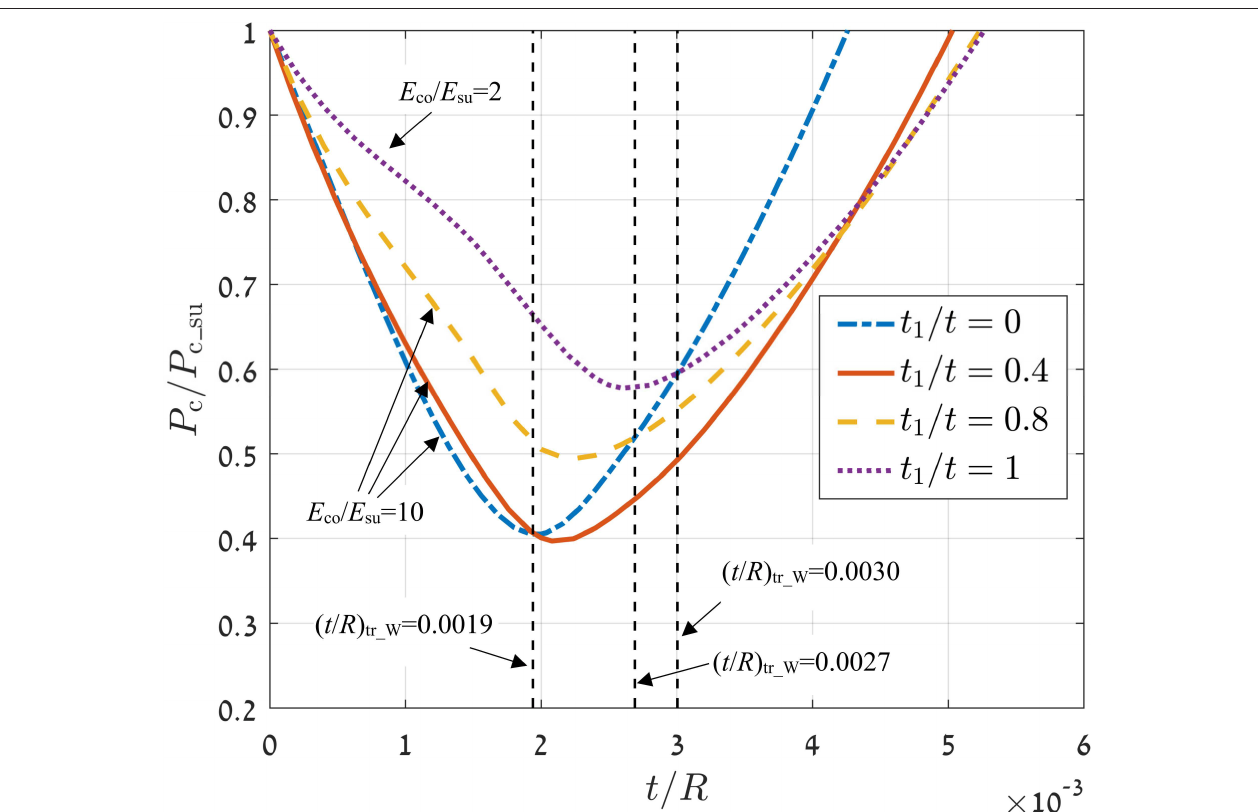
FIGURE 6 | Dimensionless critical load, P c / P c_su , vs. dimensionless coating thickness, t / R . Material properties as in Table 2 .